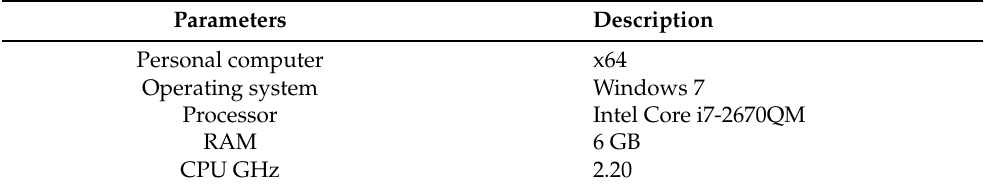
Table 1. Development